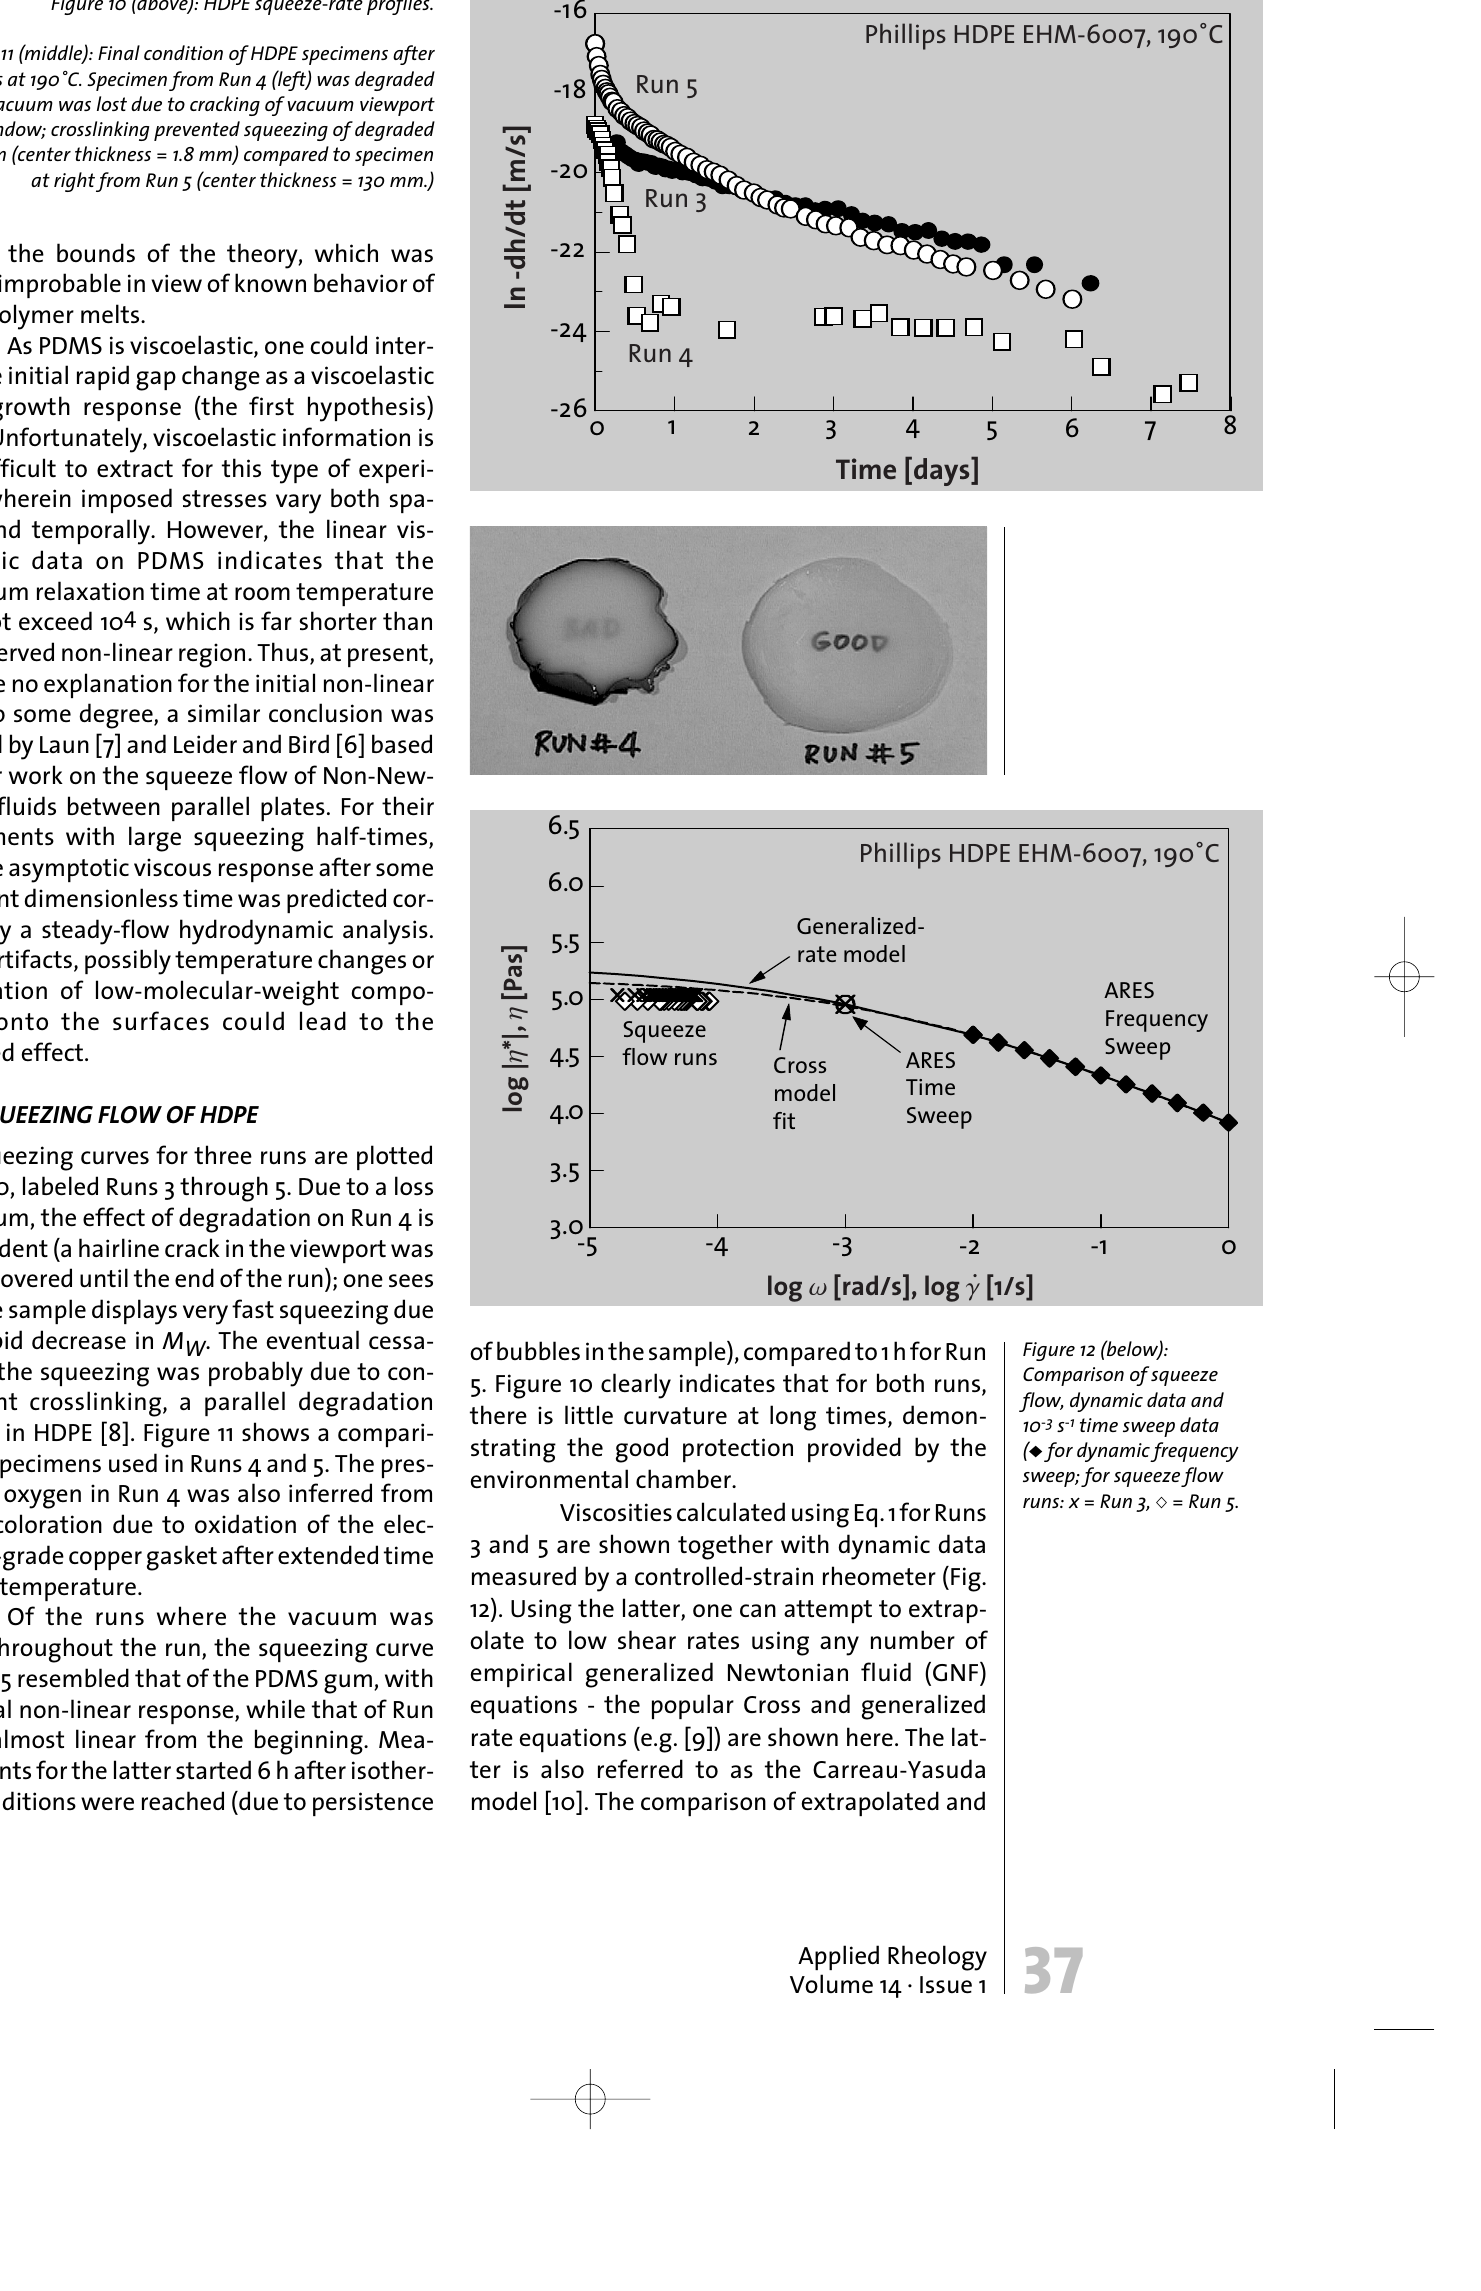
10 (above): HDPE squeeze-rate profiles. Figure 11 (middle): Final condition of HDPE specimens after 7 days at 190˚C. Specimen from Run 4 (left) was degraded when vacuum was lost due to cracking of vacuum viewport window; crosslinking prevented squeezing of degraded specimen (center thickness = 1.8 mm) compared to specimen at right from Run 5 (center thickness = 130